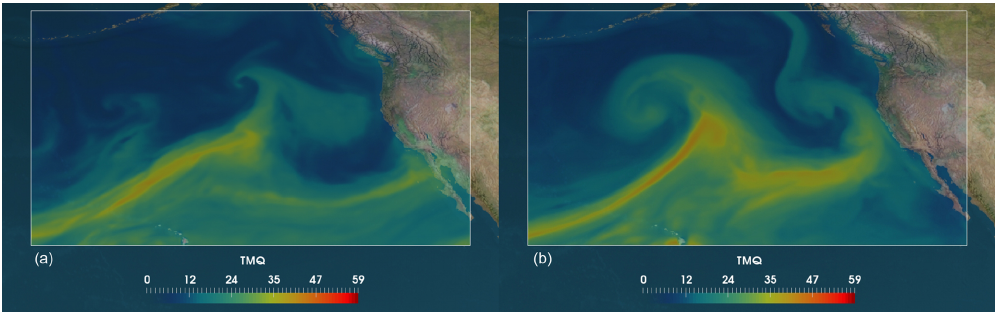
Figure 13. Sample images of events from the testing set showing a typical failure mode of the proposed method: examples of non-ARs misclassified as ARs (false positives). The figure shows IWV (kgm − 2 ) in the CAM5.1 climate model (color map) and the land–sea mass as background (satellite image). (a) The model likely fails because of the presence of two AR-like branches that are close to each other: one that has not yet made landfall and another that probably remained after the previous event. (b) The model fails likely due to the merging of two events, both with high concentrations of water vapor: one that appears to be an AR and the other likely an extratropical cyclone